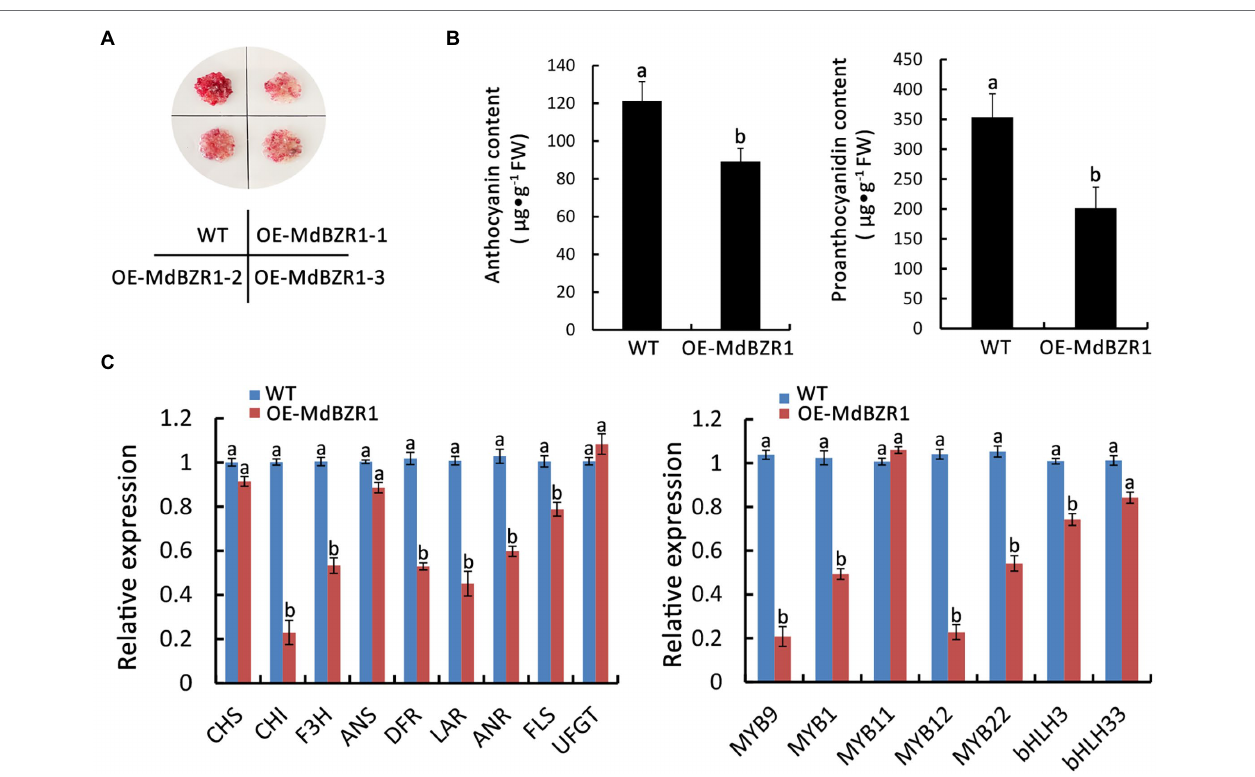
FIGURE 6 | MdBZR1 regulates the synthesis of anthocyanin and proanthocyanidin in red-fleshed apple calli. (A) Phenotypes of OE-MdBZR1 red-fleshed apple calli. (B) Anthocyanin and proanthocyanidin contents in WT and transgenic lines. (C) Expressions of the genes related to flavonoid synthesis in OE-MdBZR1 red- fleshed apple calli as determined by qRT-PCR. Statistical significance is indicated by different lowercase letters ( p < 0.05